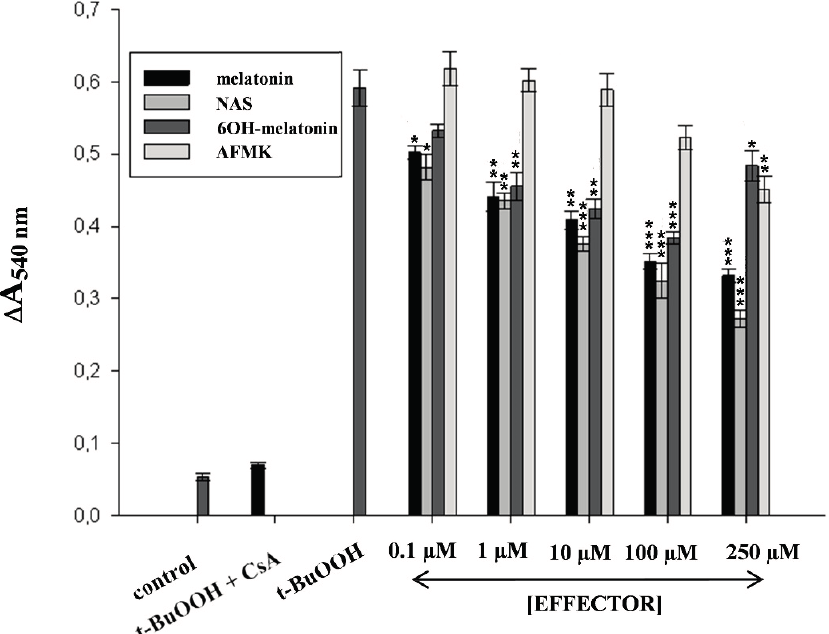
Figure 3. Effect of melatonin, 6-hydroxymelatonin, N -acetylserotonin and AFMK on t-BuOOH-induced swelling of rat liver mitochondria. Swelling was measured spectrophotometrically by monitoring the absorbance at 540 nm of suspensions of mitochondria, intact or treated with 500 µM tert-butyl hydroperoxide (t-BuOOH), with or without cyclosporin A (CsA) (5 μ M), and in the presence or absence of effectors (0.1, 1, 10, 100, 250 µM). Mitochondria were isolated and treated as described previously [83,115]. Protective effect of melatonin, 6-hydroxymelatonin, N -acetylserotonin and AFMK (mitochondria treated by t-BuOOH in the presence of effectors) compared to corresponding samples without effectors was considered statistically significant and indicated as * p < 0.05; from 3